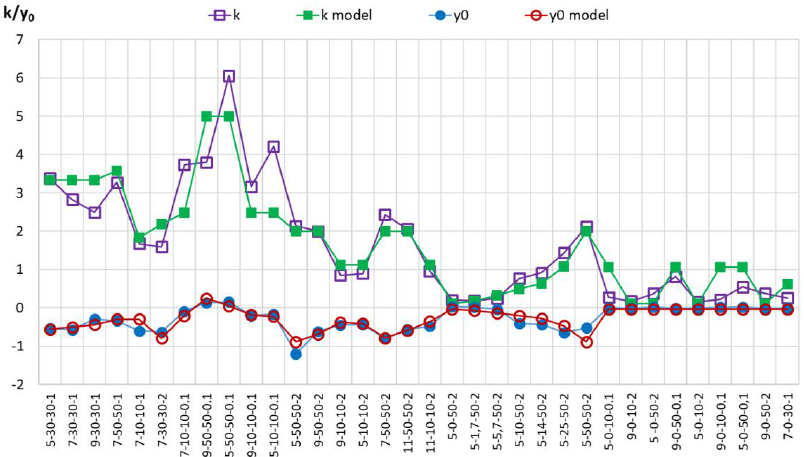
Figure 4. Comparison of k and y 0 values (experimental results versus values from models). As can be seen, overall, a good concordance of experimental and calculated points was observed. This indicates that the obtained models could be applied to the prediction of the dye decolouration behaviour in the defined range of study. Surface responses are useful tools for a better understanding of models. Figure 5 shows the different response surfaces plotted for the model of k (Equation (5)).